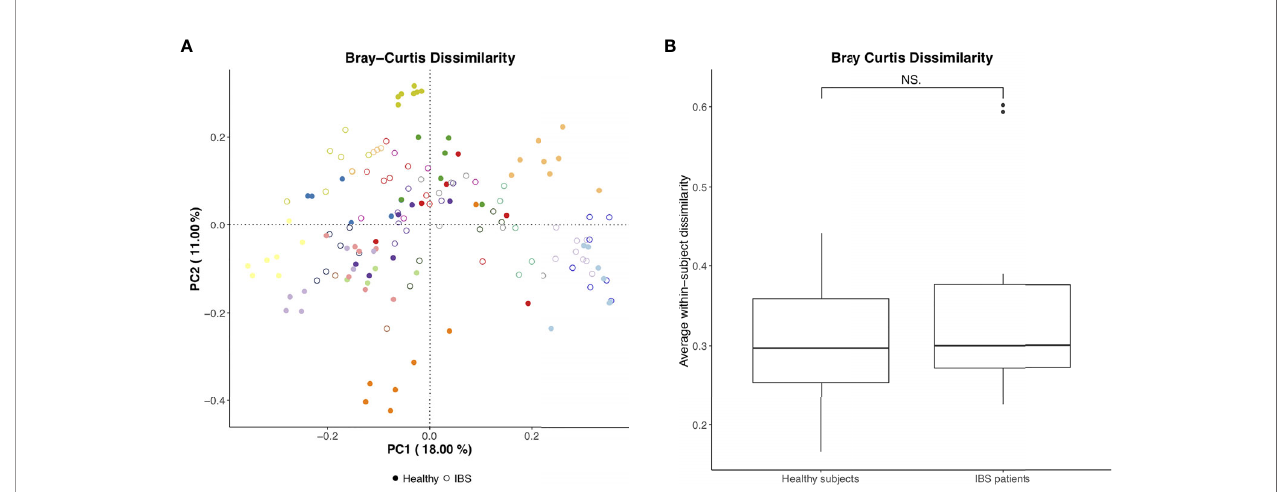
FIGURE 1 | (A) Bray Curtis PCoA plot per individual (different colors) and for healthy subjects vs. IBS patients ( fi gure annotations). (B) Average within-subject beta diversity (Bray Curtis Dissimilarity) for healthy subjects vs. IBS patients, signi fi cance tested using Mann Whitney U test, NS, not signi fi cant